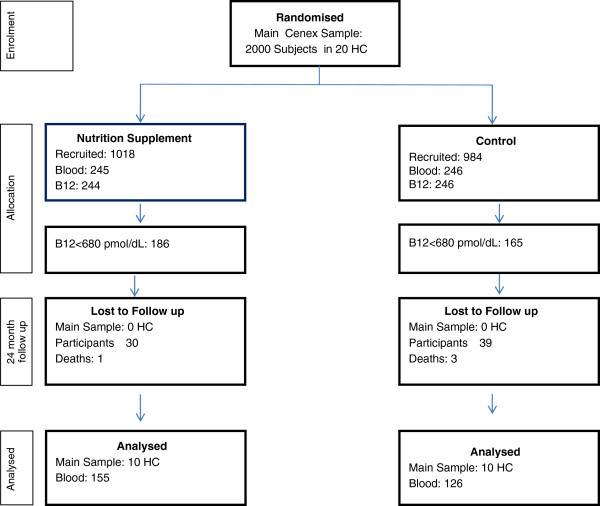
Flow-chart for study.